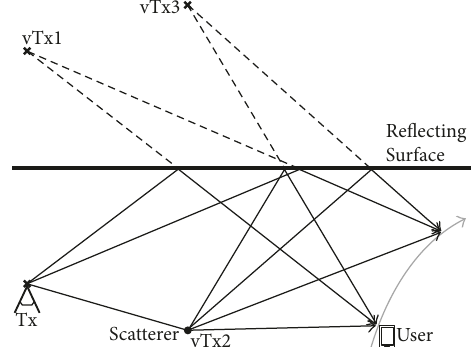
Figure 1: Signals from the physical transmitter Tx are received at the two user positions via different propagation paths. Each MPC arriving at the receiver is regarded as being transmitted by a virtual transmitter in a pure LoS condition. The propagation paths correspond to a reflection at the wall (vTx1), a scattering at a point scatterer (vTx2), and a scattering followed by a reflection at the wall (vTx3).